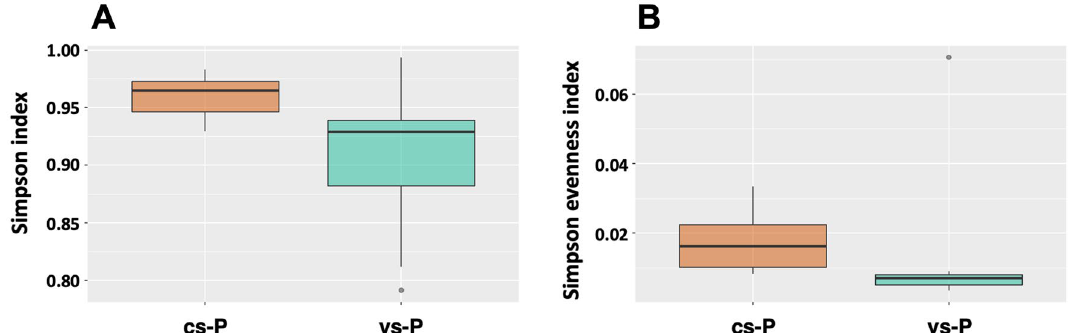
Figure 1. Alpha diversity measured as Simpson index and calculated as 1-D ( A ) and Simpson evenness index ( B ). Samples from nasal microbiota of 15-day-old piglets born to control unvaccinated sows (cs-P, orange boxes) and to vaccinated sows (vs-P, green boxes) with a vaccine against virulent G. parasuis were analyzed. These two indexes resulted statistically significant ( P <